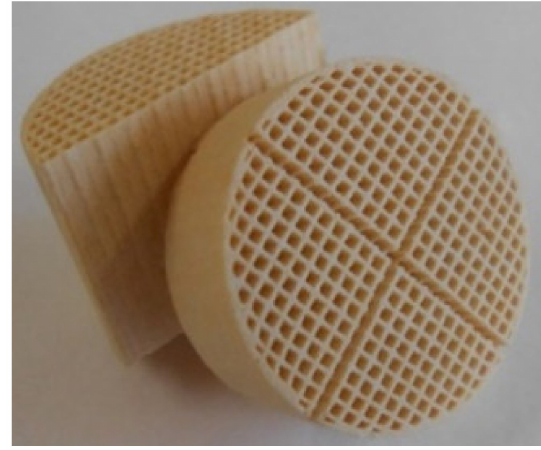
Figure 3. Cordierite monolith used in this work.